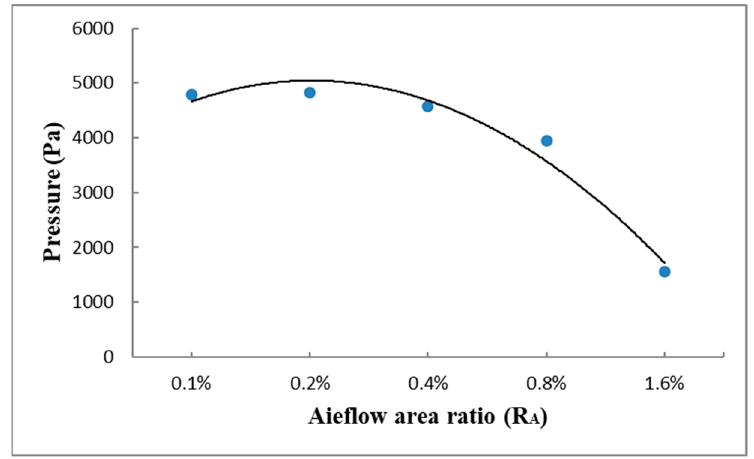
Figure 11. Air-pressure corresponding to area ratio of orifice cross-section.